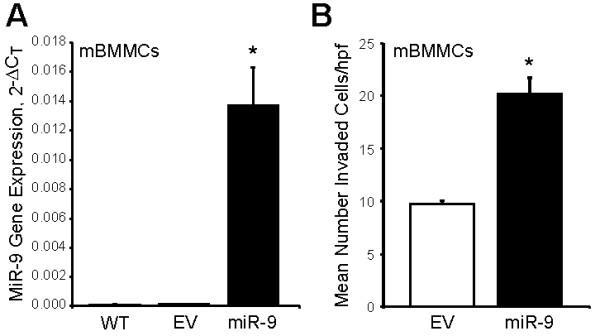
Overexpression of miR-9 enhances invasion in normal mouse bone marrow-derived mast cells. (A) Normal mBMMCs transduced with pre-miR-9-3 lentivirus or empty vector control were sorted to greater than 95% purity based on GFP expression. MiR-9 levels were assessed by real-time PCR (*p < 0.05). Three independent experiments were performed and all reactions were performed in triplicate. (B) mBMMCs transduced with either empty vector or pre-miR-9-3 lentivirus were transferred onto cell culture inserts coated with Matrigel® for 24 hrs. After incubation, cells remaining on the upper surface of the insert membrane were wiped away using a cotton swab, and cells that had migrated to the lower surface were stained with crystal violet and counted in ten independent 20x hpf for each sample. Three independent experiments were performed and all samples were performed in triplicate wells (*p < 0.05).